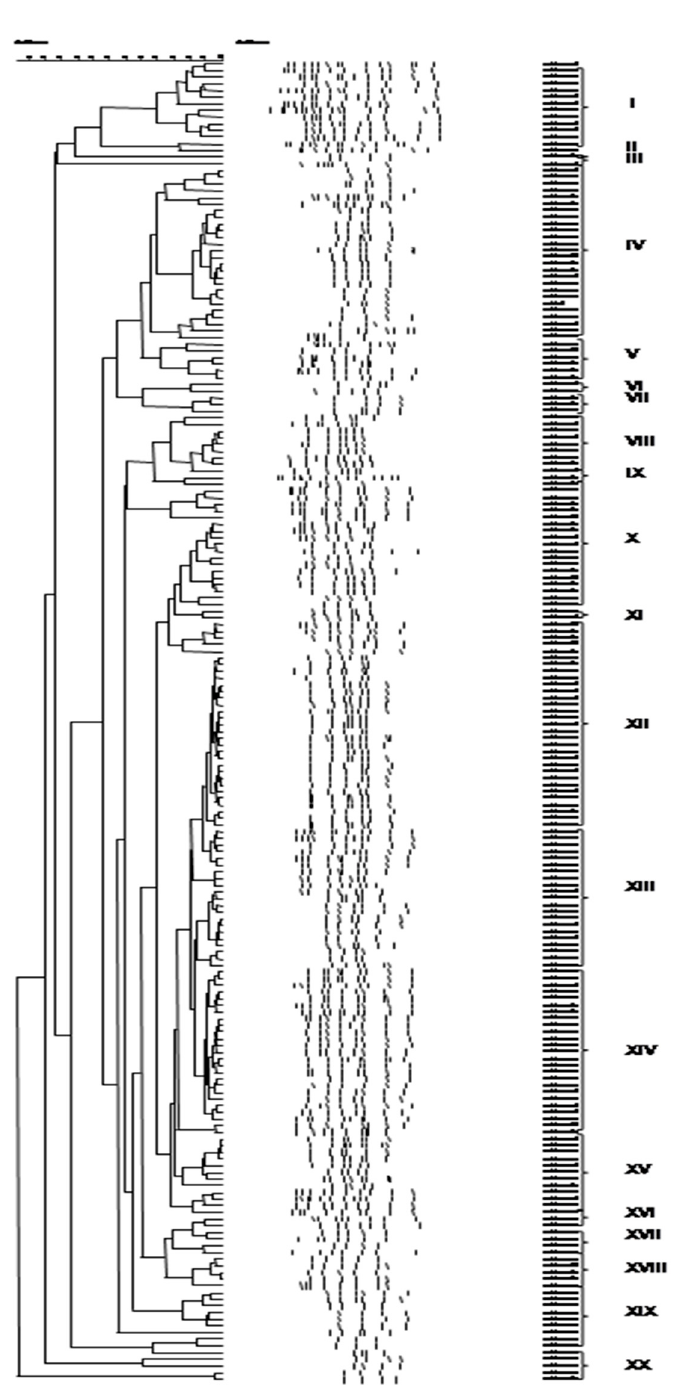
Figure 3. Cluster analysis of PCR-RAPD patterns of yeast isolates, obtained from 13 Greek wheat sourdoughs. Distance is indicated by the mean correlation coefficient [r (%)] and clustering was performed by UPGMA analysis. The representative strains selected for 26S rRNA gene sequencing are underlined. Latin numerals designate yeast species (I, VI and XVI: P. membranifaciens , II, IV, V, VIII, X, XII, XIII, XIV, XV, XIX and XX: S. cerevisiae , III, IX and XVIII: P. fermentans , VII and XVII: W. anomalus , XI: K. humilis ).